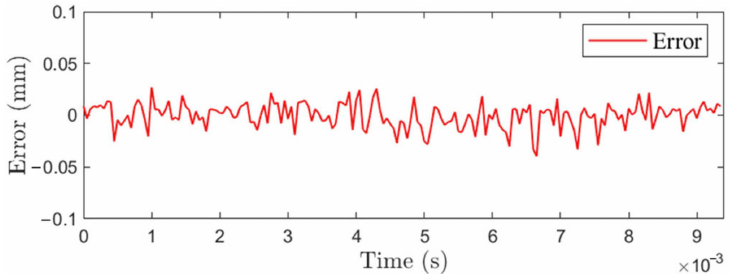
Figure 13. Suspension system tracking control error